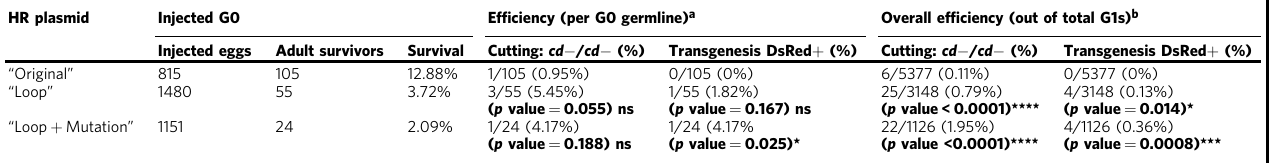
Aone-tailrandomizationtestforadifferenceinproportionswasperformedtodeterminewhethertheLooportheLoop + mutationscaffoldvariantscausedanincreaseintransgenesiswhencomparedto the “ Original ” gRNA; the obtained p values are reported in the table in bold type for these comparisons for either the “ Ef fi ciency per G0 germline ” or “ Overall ef fi ciency (G1) ” along with the signi fi cance expressed in using the asterisk convention. ns not signi fi cant. a G0 germline cutting and transgenesis ef fi ciencies were calculated as numbers of independent pools that produce either cd − /cd − mutant (cutting) or DsRed + (transgenesis) animals, divided by the total number of crossed G0s. While each pool contains several G0 individuals, our calculations assume only one editing event happened in each positive pool and may underestimate the cutting and transgenesis rates. b Theoverallcuttingandtransgenesisef fi ciencieswerecalculatedasthenumberofG1individualswitheither cd − /cd − (cutting)orDsRed +